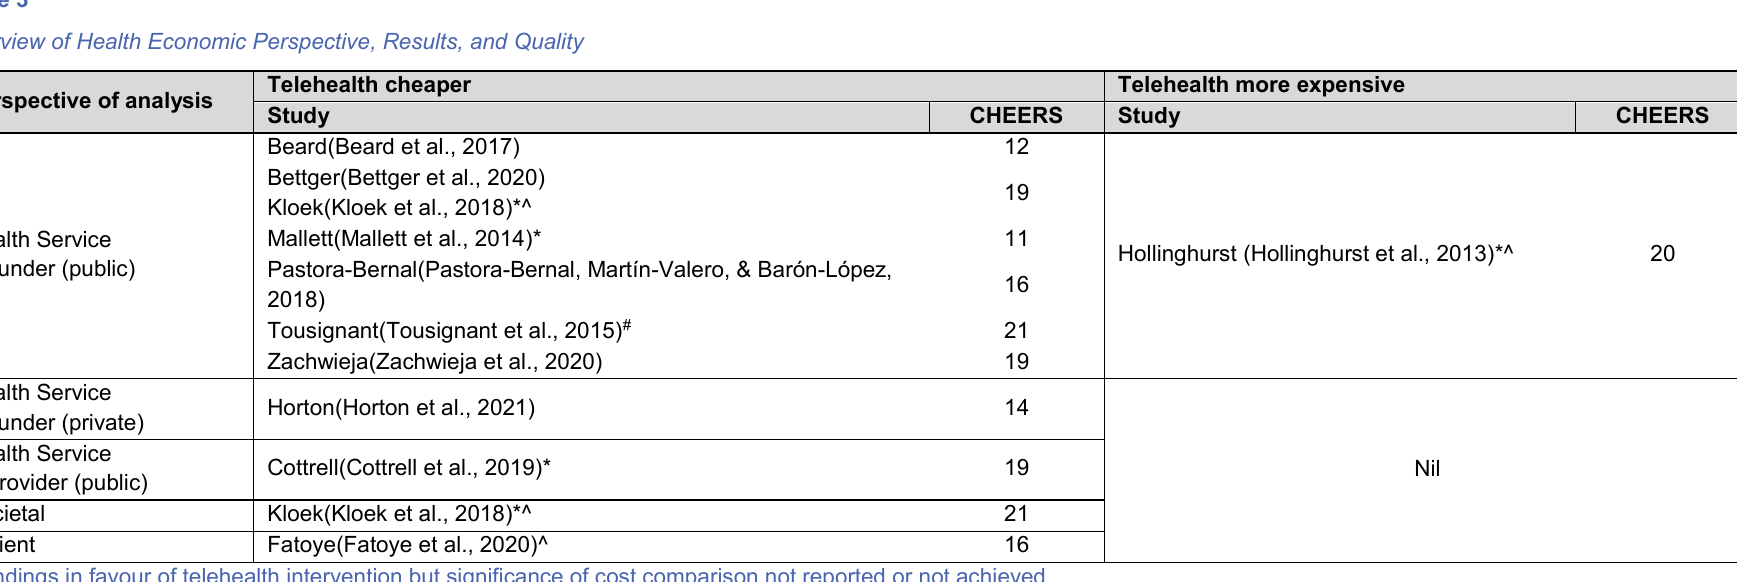
Overview of Health Economic Perspective, Results, and